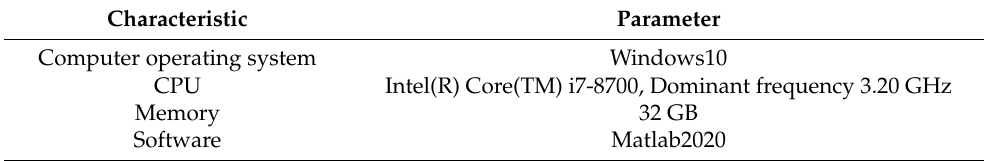
Table 1. Computer platform